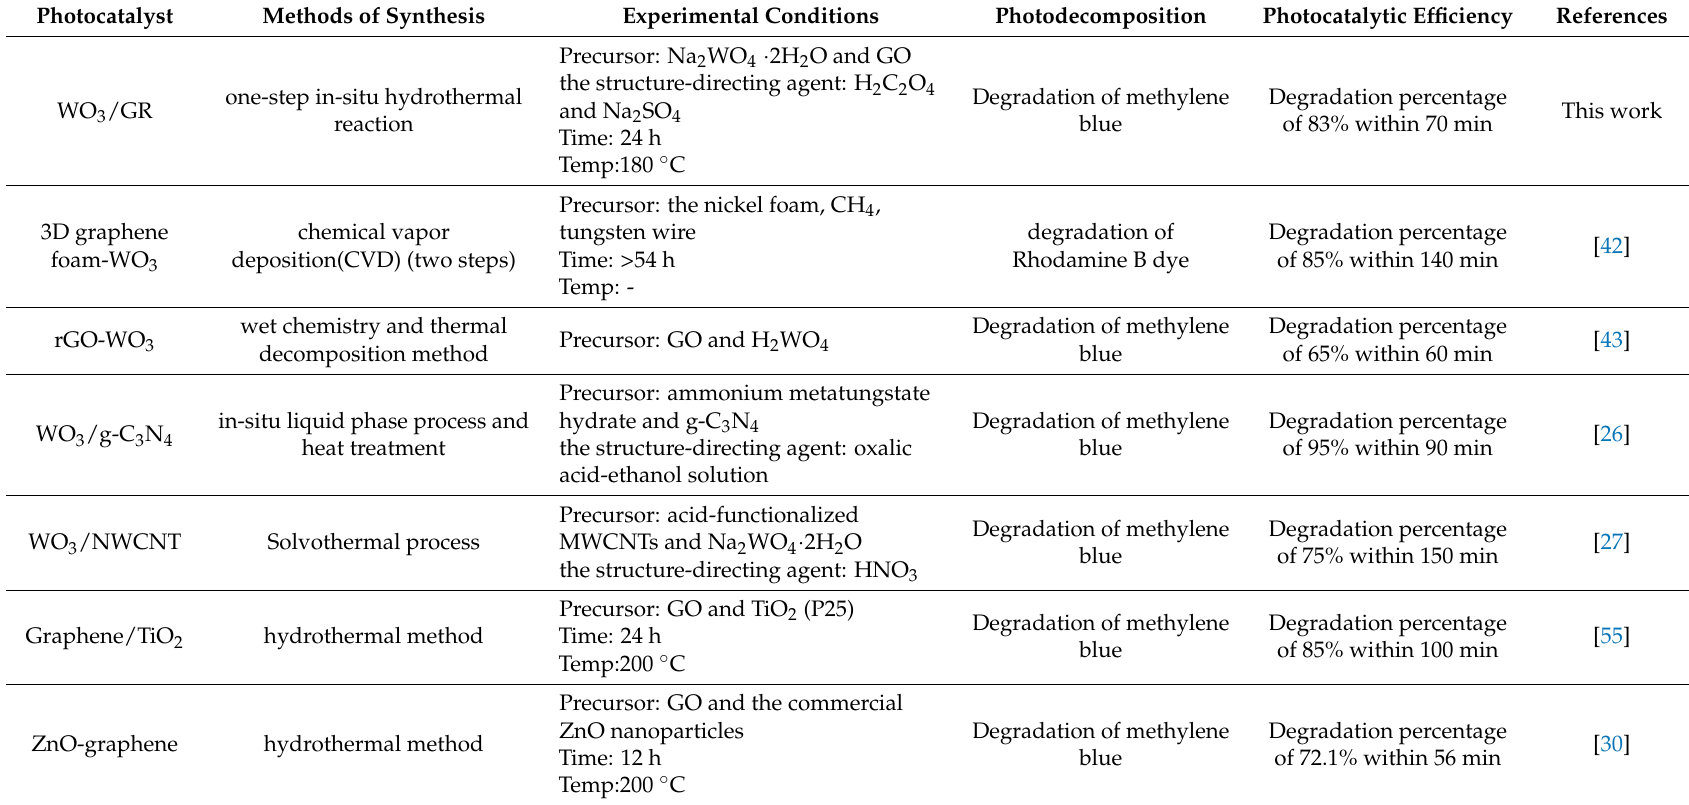
Table 1. Comparison of photocatalytic performance between this work and reported